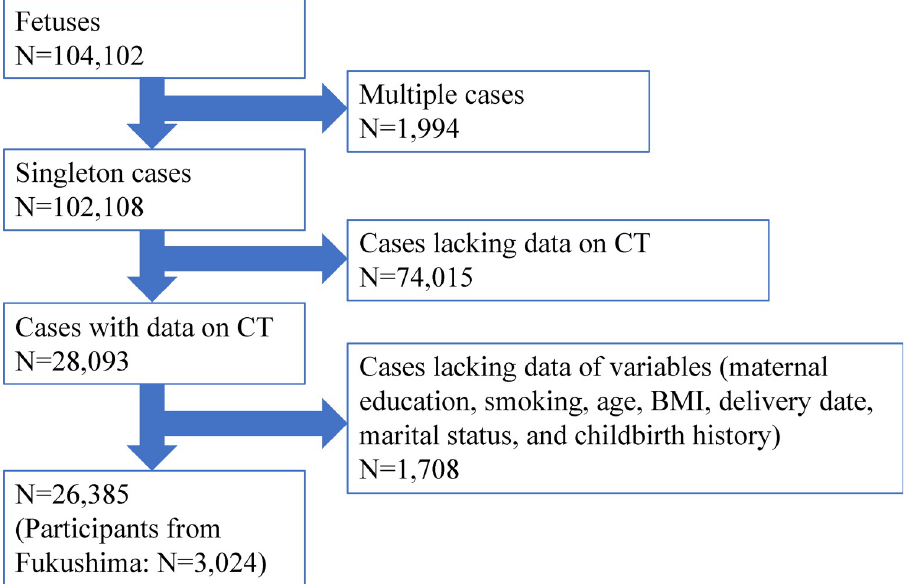
Fig 1. Flowchart of the recruitment of study participants. On application of the eligibility criteria, 26,385 mothers were considered to be eligible from the data obtained on 104,102 fetuses from the JECS. Of these, 3,024 cases from the Fukushima prefecture were enrolled in this study. Abbreviations: CT: Chlamydia trachomatis ; BMI: body mass index.